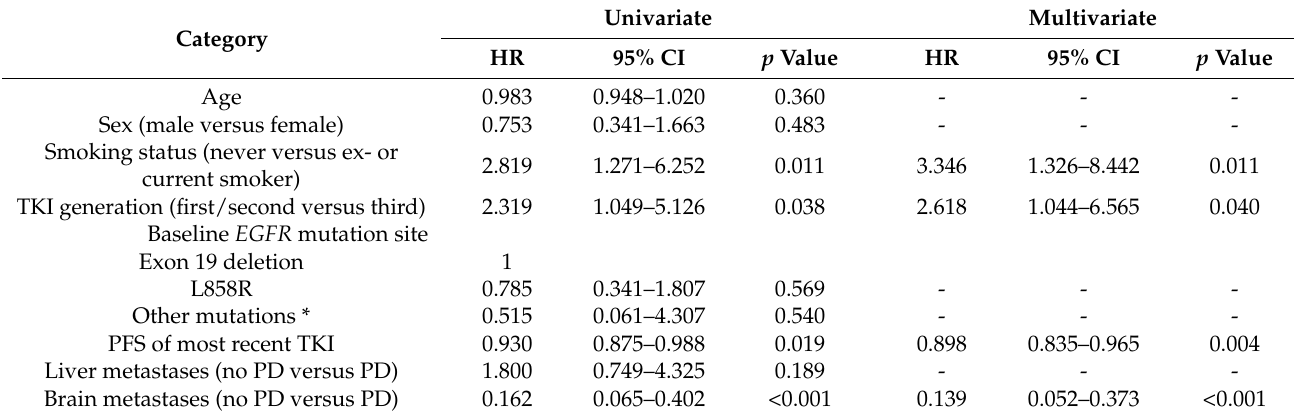
Table 2. Logistic regression analysis of clinical factors predicting MET amplified